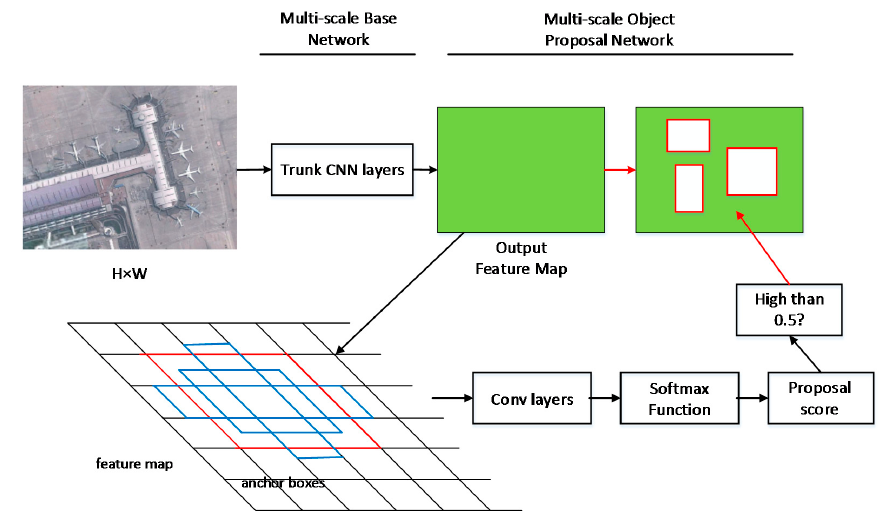
Figure 5. Architecture of the multi-scale object proposal network.